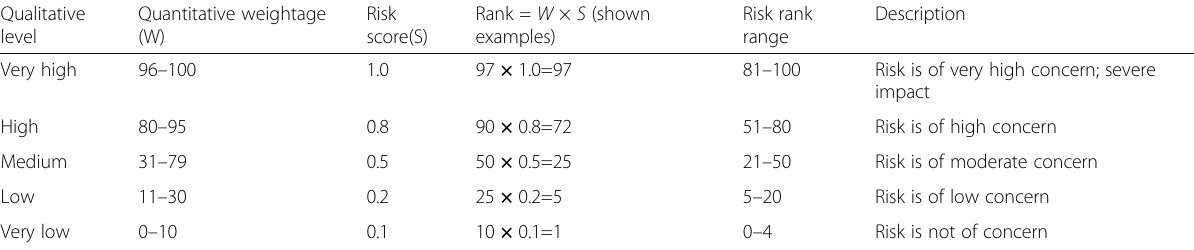
Table 4 Risk rank